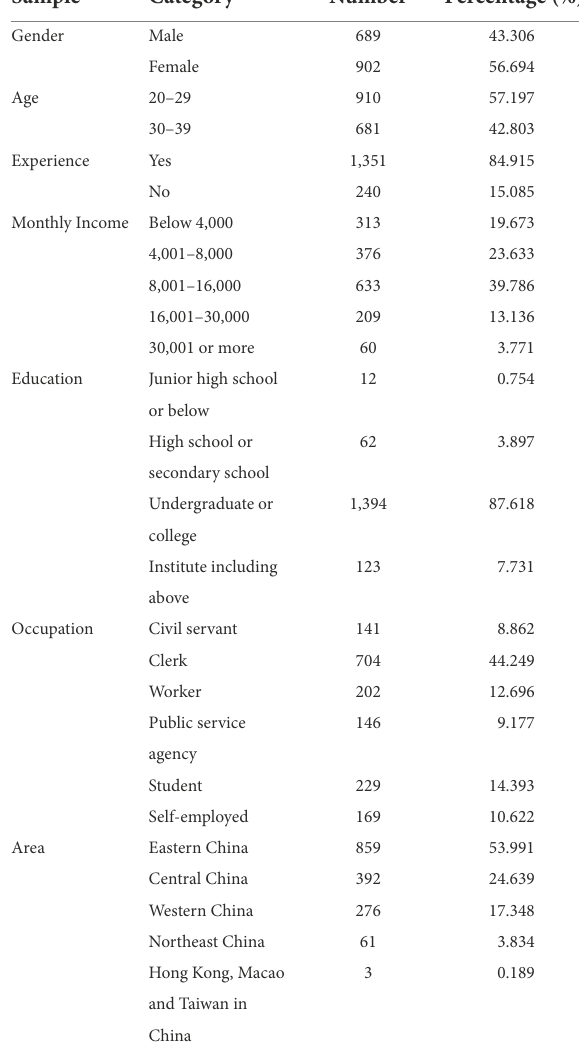
TABLE 1 Demographic characteristics of the